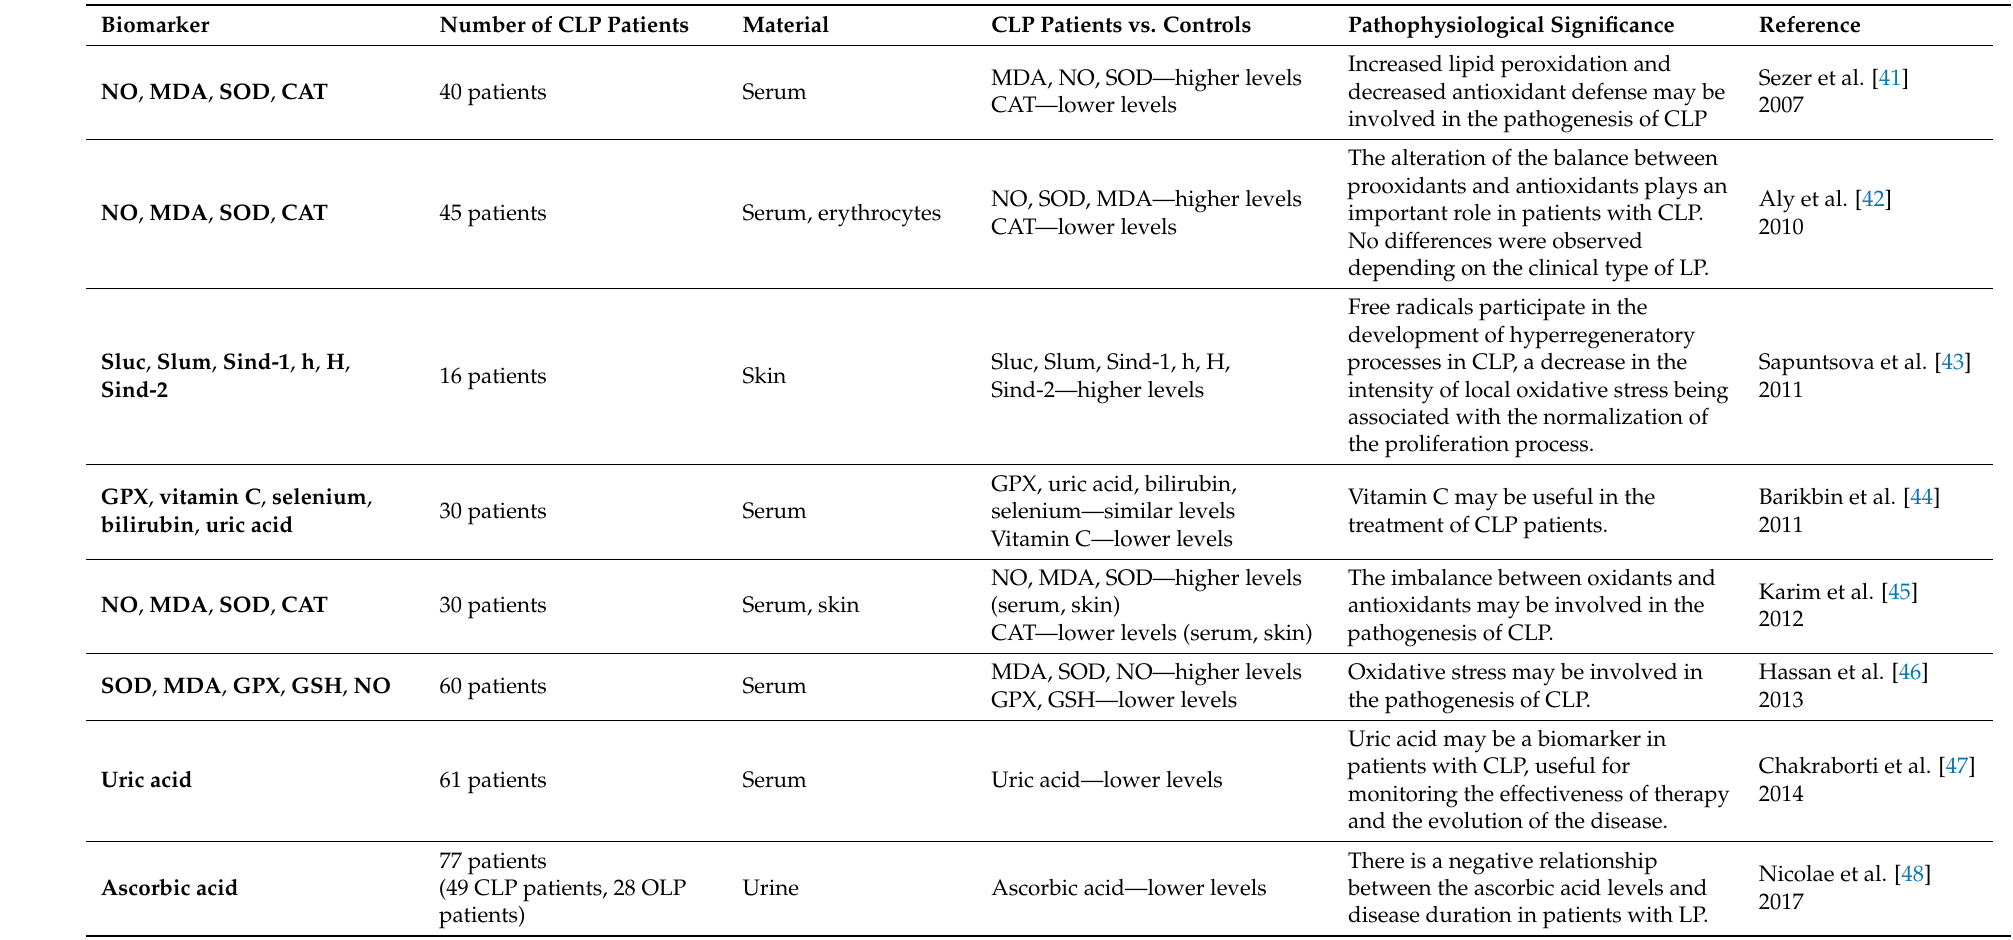
Table 1. Summary of the studies included in the